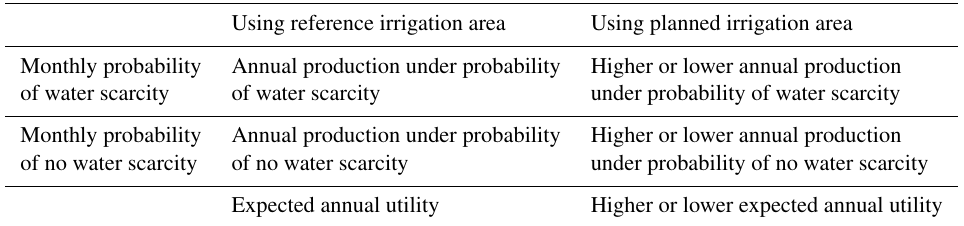
Table 1. Evaluating the expected annual utility using the planned irrigation area from selected river discharge information relative to expected annual utility using the reference irrigation